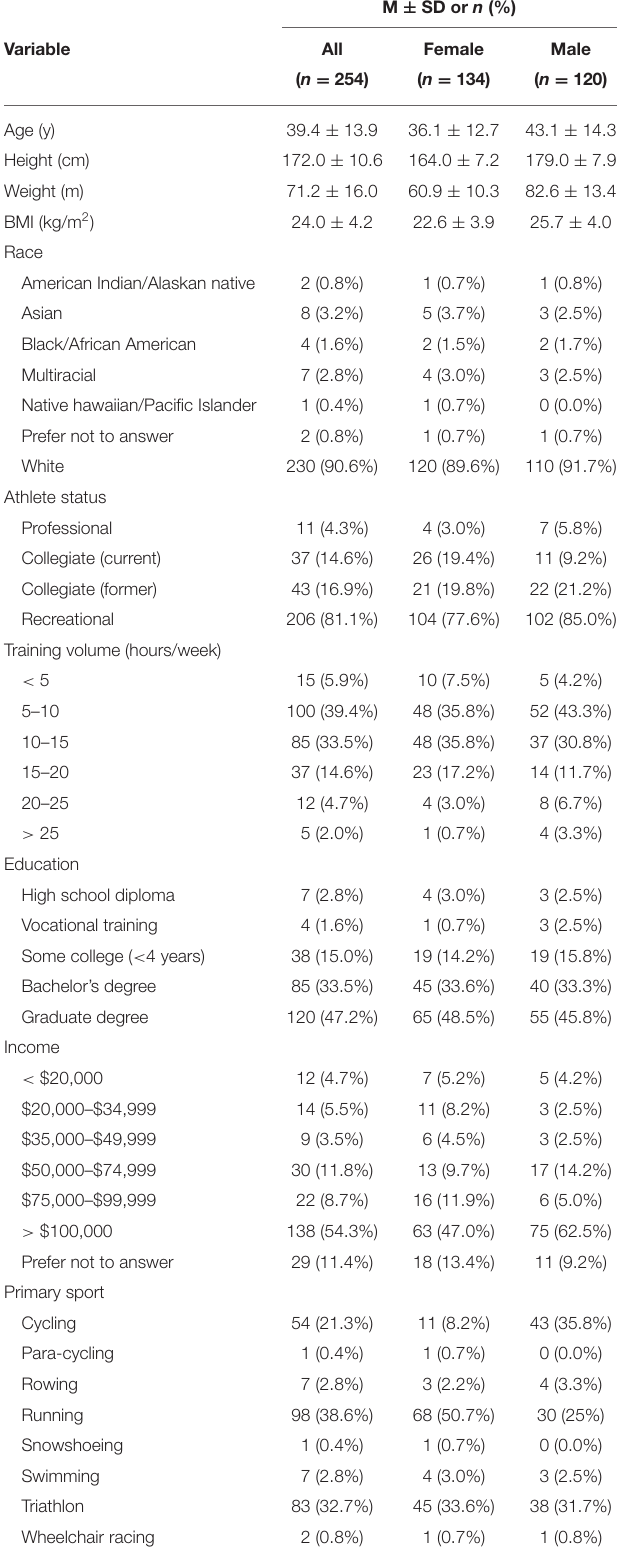
TABLE 1 | Participant